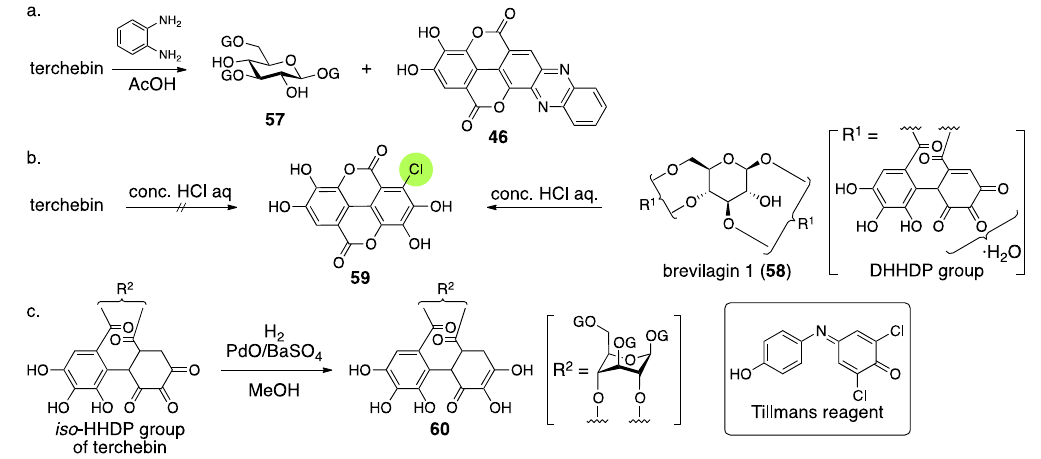
Figure 26. The transformations used for the structural revision to 56 .